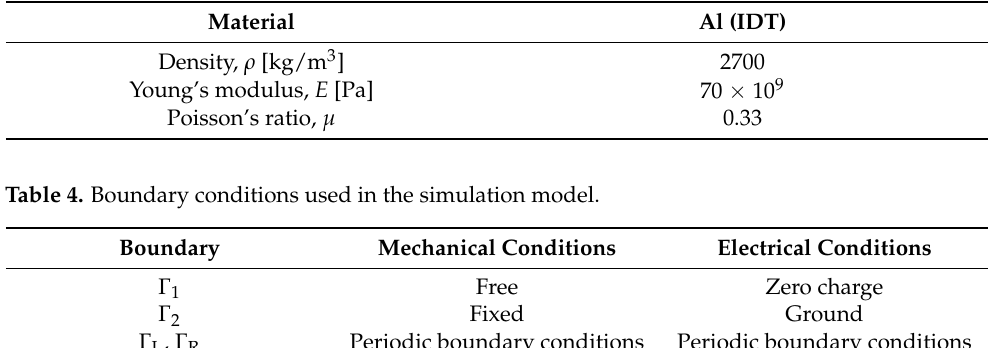
Table 3. Material parameters of IDT in the simulation model.